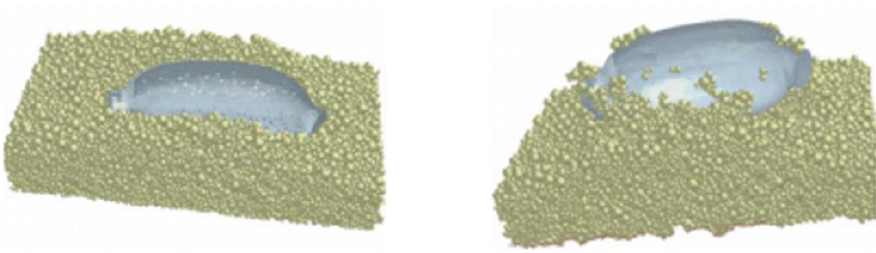
Figure 14. Pull-out process of semi-buried lotus roots in EDEM simulation.